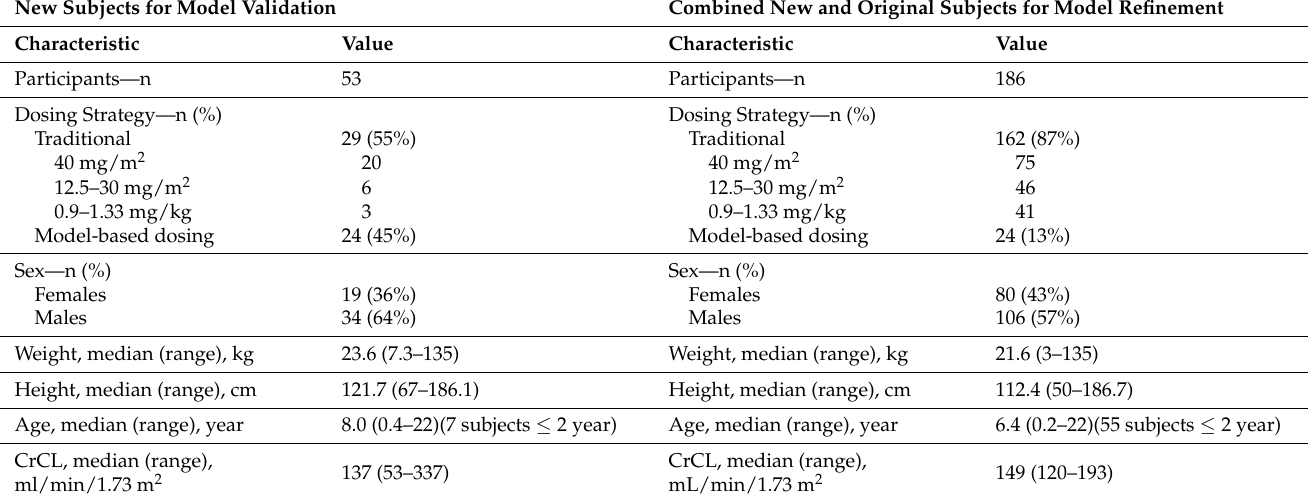
Table 1. Subject Demographics and Baseline